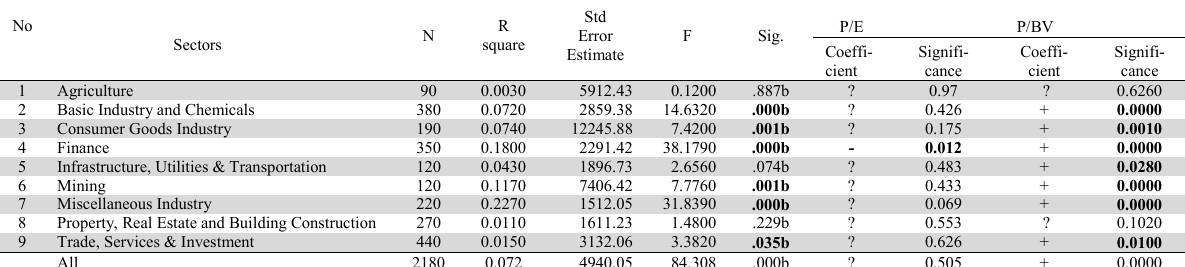
Statistical Analyses Result of Industry Sectors during